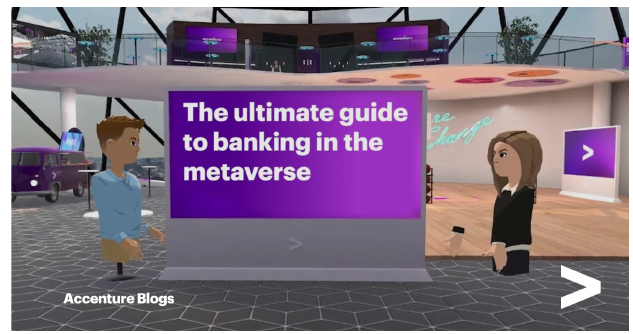
Figure 32: Accenture’s guide to banking in the metaverse